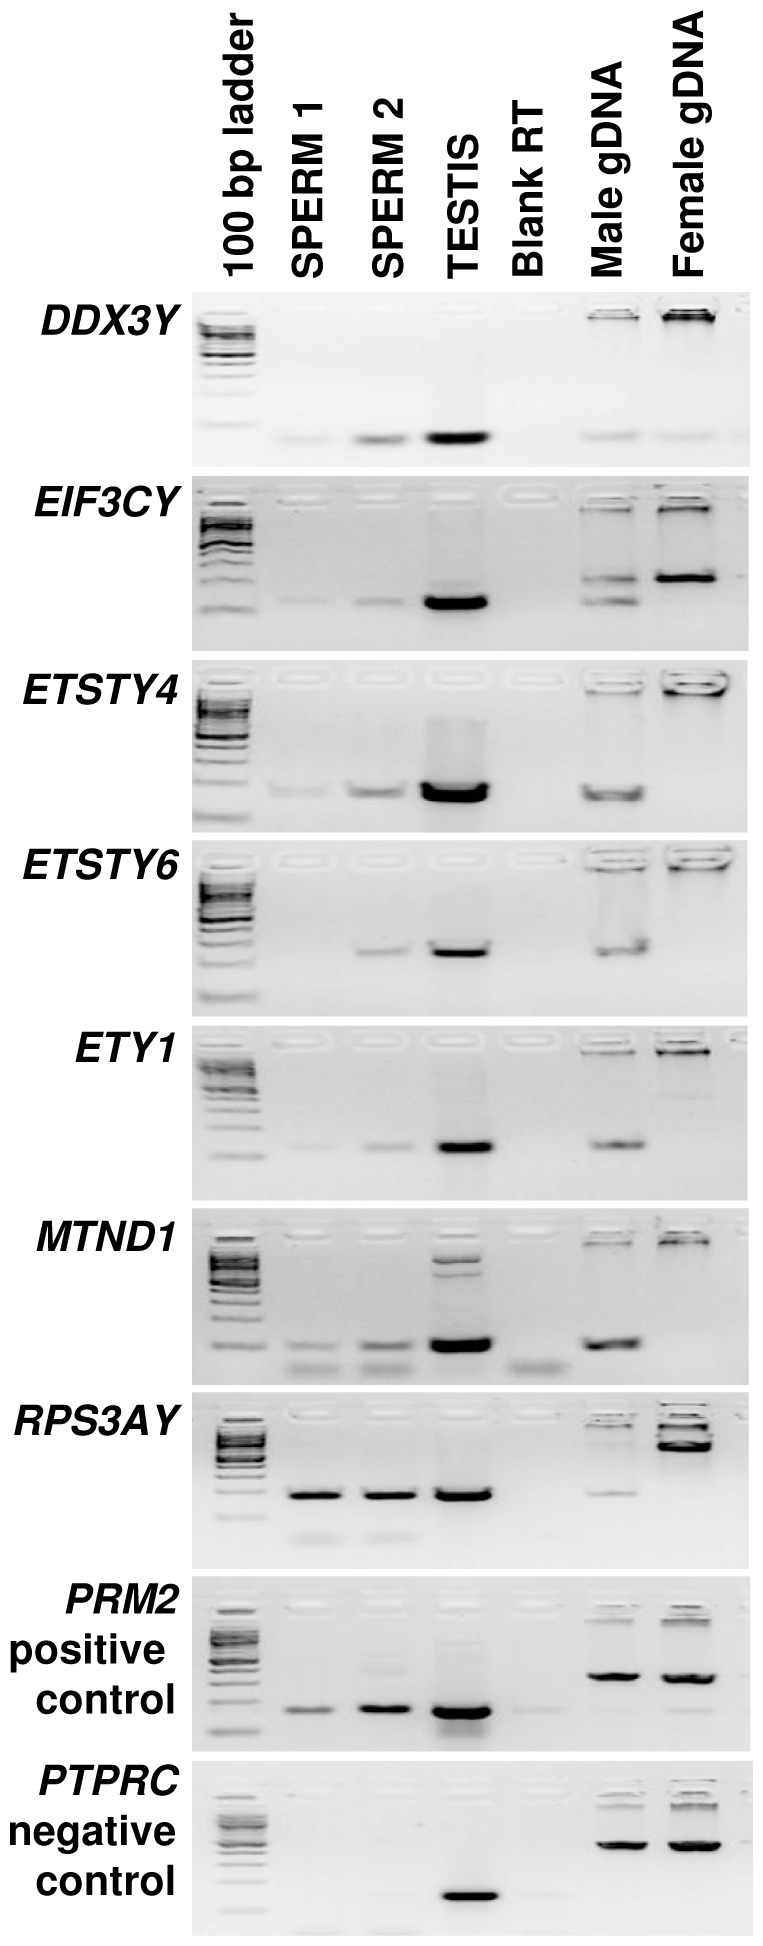
ECAY transcripts in stallion sperm.Agarose gel images showing RT-PCR amplicons of 7 ECAY genes and transcripts in stallion sperm.